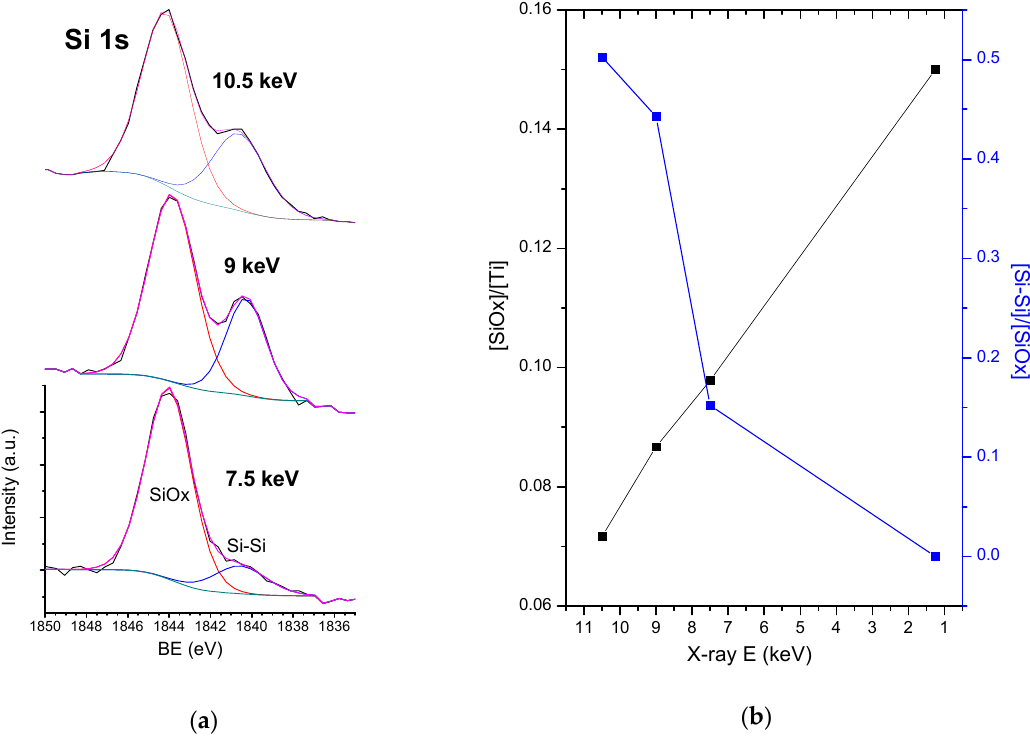
Figure 7. HAXPES analysis of an APhTS / TIPT condensed film. ( a ) Experimental and fitted spectra of the Si 1s peak obtained at 7.5, 9.0 and 10.5 x-ray beam energy (from bottom to top). ( b ) Evolution of [SiO x ] / [Ti] and [Si-Si] / [SiO x ] as a function of x-ray beam energy. Note inclusion of additional data from conventional XPS analysis.